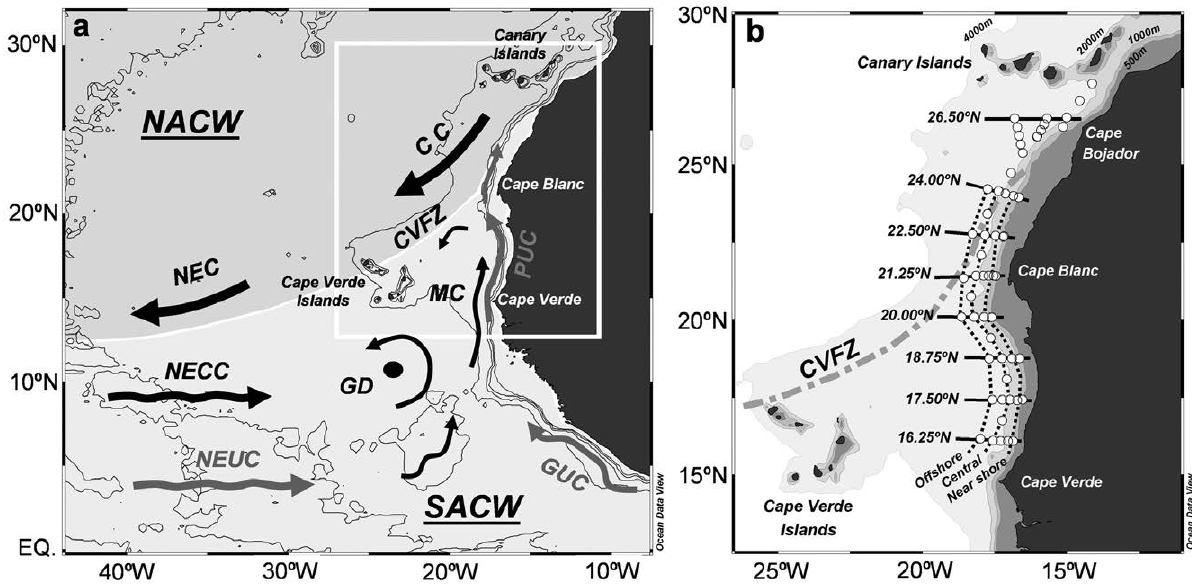
F ig . 1. – Left panel: Schematic pattern of the circulation showing the main currents and dynamic features: Canary Current (CC), North Equa- torial Current (NEC), North Equatorial Counter Current (NECC), North Equatorial Under Current (NEUC), Poleward Undercurrent (PUC), Mauritania Current (MC), Guinea Undercurrent (GUC), Guinea Dome (GD) and Cape Verde Frontal Zone (CVFZ). Right panel: Map of the study area showing the hydrographic stations and the cross and along-slope sections used in this work. Contours of 500, 1000, 2000 and 4000 m isobaths are grey coloured. The near-shore and central meridional sections approximately follow the 1000 and 2000 m